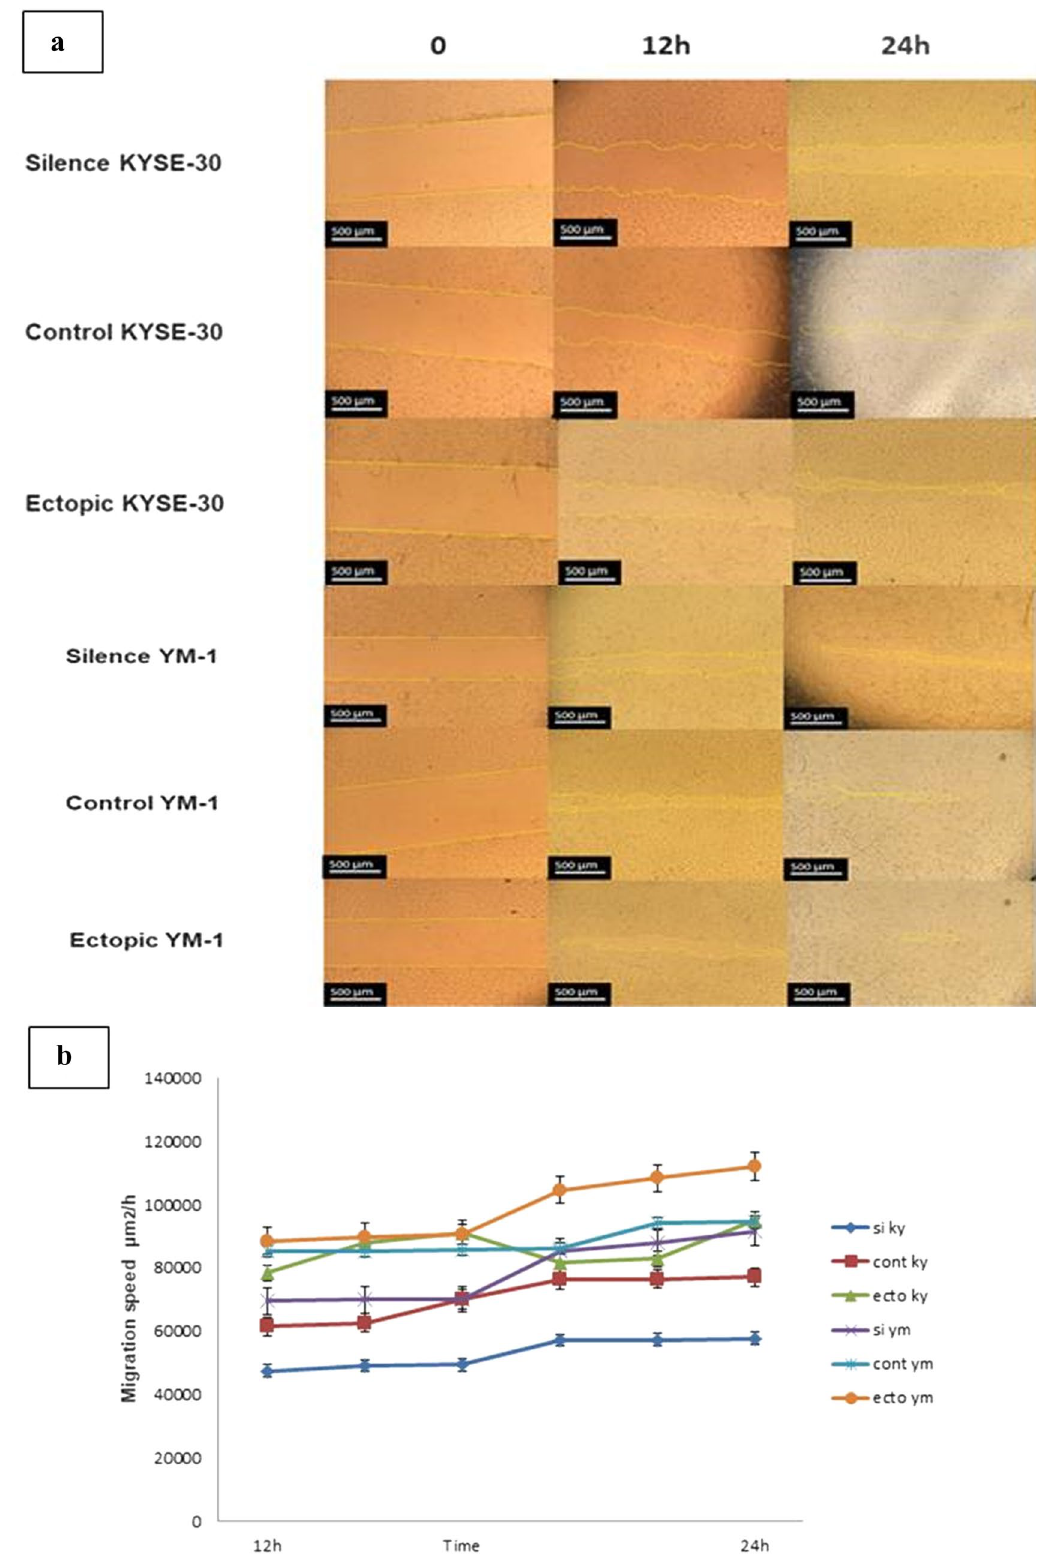
Figure 5. ( a ) Wound healing assays in ESCC lines treated overexpressing and underexperssion of EZH2 relative quantification of the effects observed anlyzed by Image j software. ( b ) Migration speed of ESCC cells was demonstrate more migration speed in EZH2-ectopic cells (μm 2